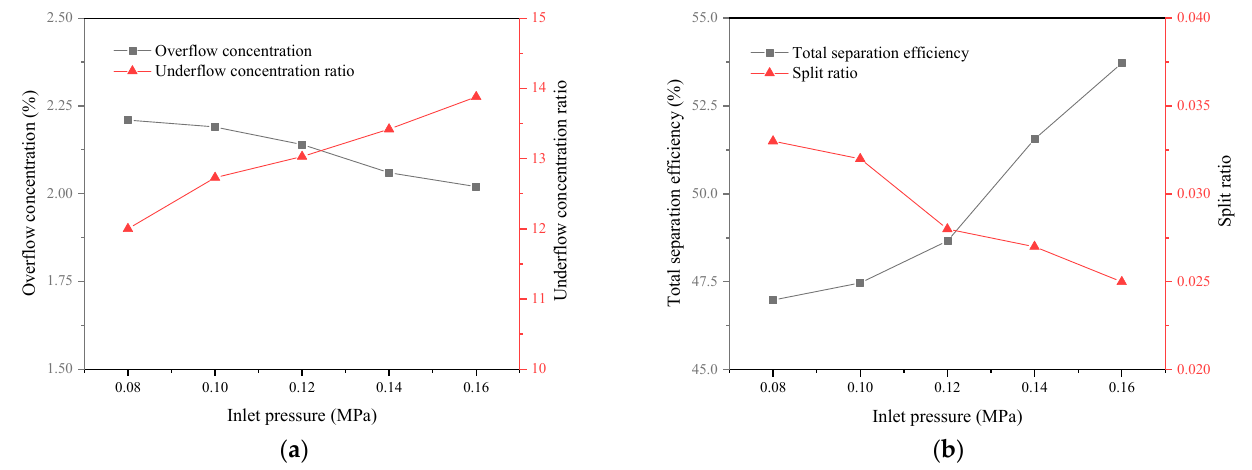
Figure 7. Effect of the feed pressure on the separation performance of the hydrocyclone. ( a ) Product concentration. ( b ) Product distribution.